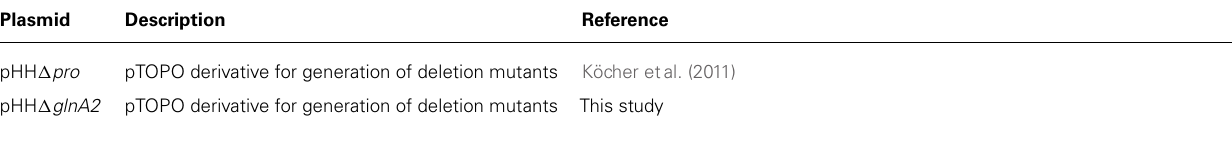
Table 3 | Plasmids used in this